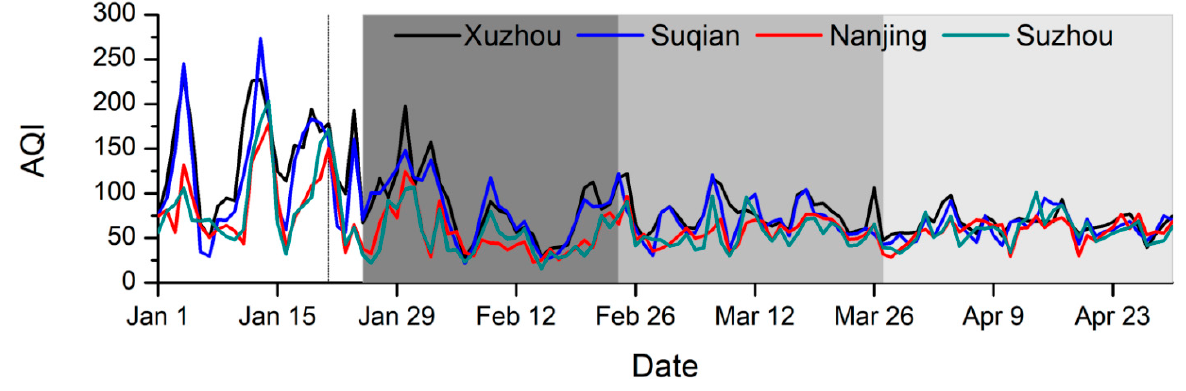
Figure 5. Daily variations of AQI in Xuzhou, Suqian, Nanjing and Suzhou in 2020. The shadows of dark grey, medium grey and light grey represent the L1, L2 and L3 period respectively. Table 5. GDP rankings of 13 prefecture-level cities in Jiangsu Province (data from the National Bureau of Statistics of China, http://www.stats.gov.cn/, accessed on 10 March 2022).